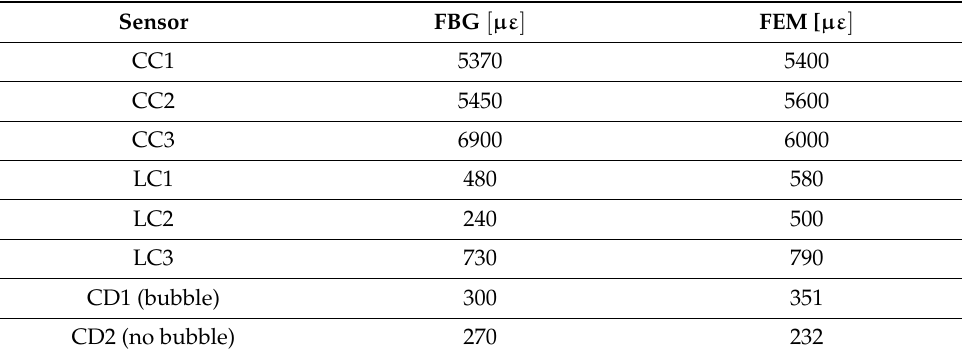
Figure 14. Strain along the cylinder part of the liner with FBG sensor location indication. Table 3. Strain measured with FBG sensors compared with FEM